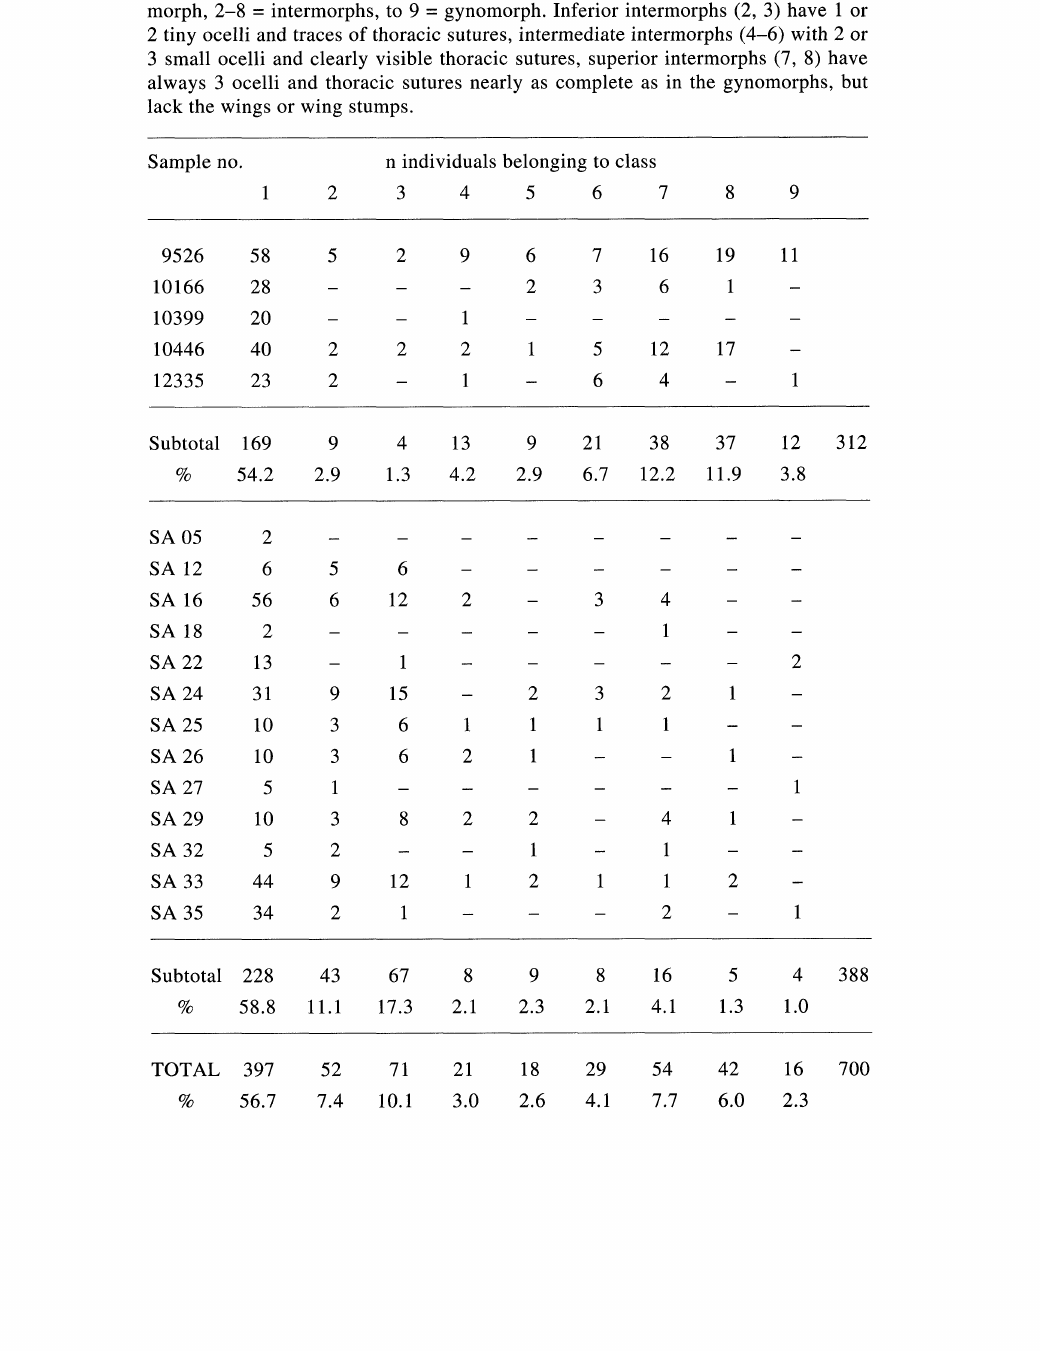
Psyche [Vol. 98 Table II: Polymorphism of females in individual samples of Leptothorax sphag- nicolus from Saint-Ambroise. The individuals are rated in a series from ergato- morph, 2-8 intermorphs, to 9 gynomorph. Inferior intermorphs (2, 3) have or 2 tiny ocelli and traces of thoracic sutures, intermediate intermorphs (4-6) with 2 or 3 small ocelli and clearly visible thoracic sutures, superior intermorphs (7, 8) have always 3 ocelli and thoracic sutures nearly as complete as in the gynomorphs, but lack the wings or wing